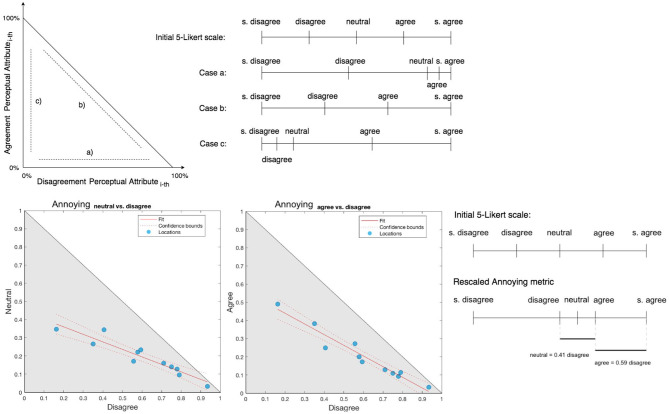
(Top) Boundary cases of regression slopes of percentage of agreement and disagreement grouped categories for a given perceptual attribute across multiple soundscapes. (Bottom) Instance of application of the rescaled on the annoying metric. The two regression slopes are then used to rescale coherently the metrics. The rescaled version of annoying metric, reported in this example, is different from the final version presented later in Figure 5 as, in this case, the metric is not enriched with information from the other scales.